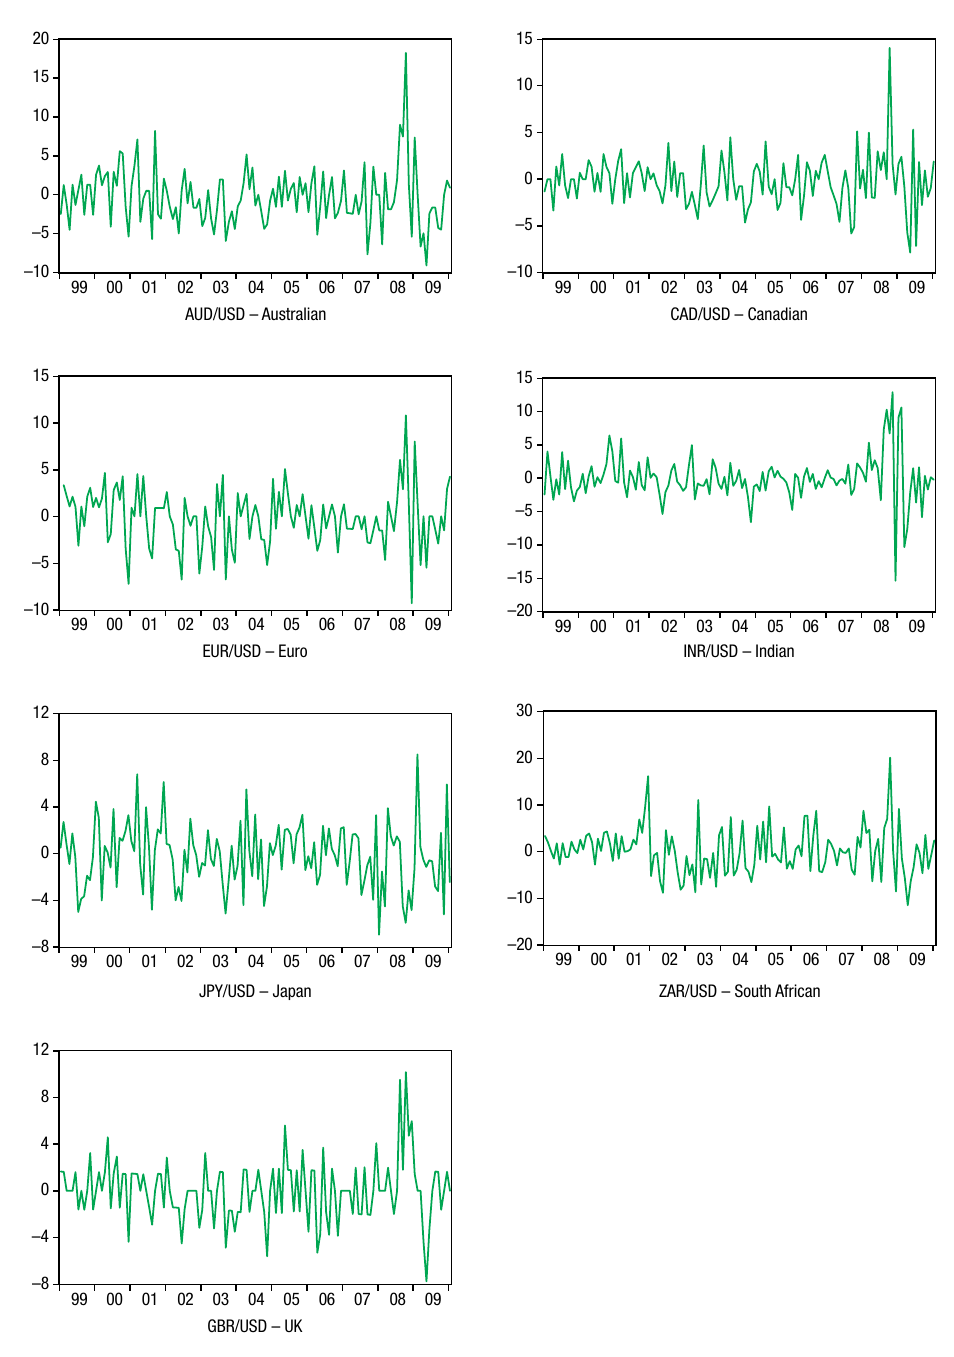
Fig. 6. The trends of the exchange rate